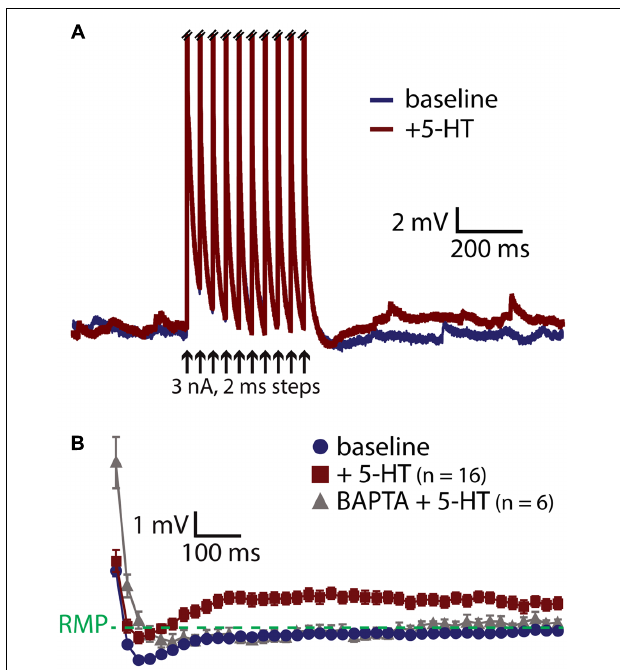
FIGURE 3 | 5-HT induces a calcium-dependent afterdepolarization (ADP) in COM neurons. (A) Voltage traces from a COM neuron experiencing a train of ten high-amplitude (3 nA, 2 ms, 25 Hz) current injections in baseline conditions (blue) and following focal application of 5-HT (red). Action potentials are truncated. Black arrows indicate current step applications. (B) Average voltage responses following spike trains paired with 5-HT, resampled to 50 Hz and plotted as mean ± SEM, for 16 neurons in baseline conditions (blue) and after 5-HT (red). Gray symbols show responses following 5-HT application in a different group of COM neurons filled with 10 mM BAPTA ( n